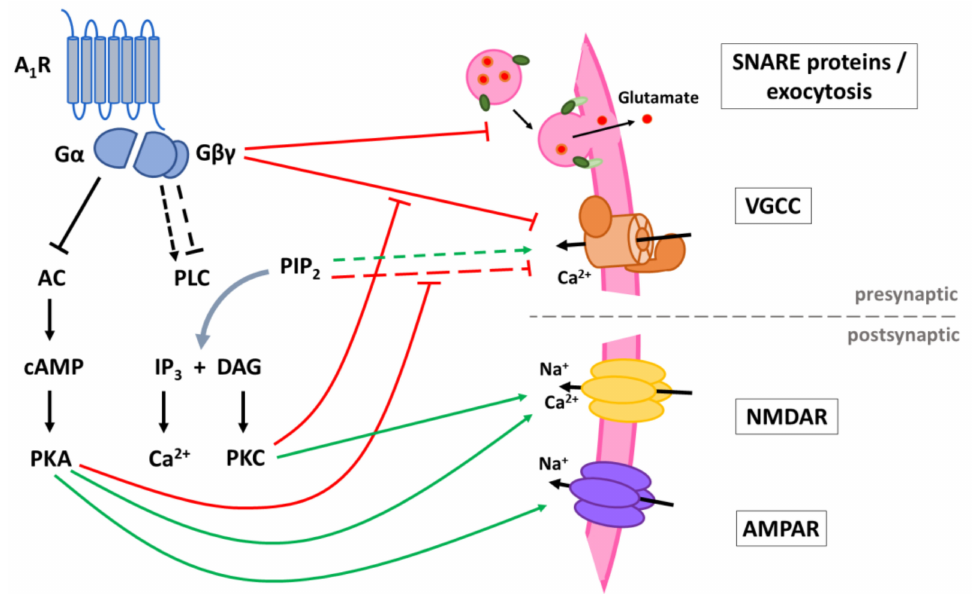
Figure 4. Schematic representation of the signaling pathways involved in the suppression of neurotransmission by adenosine A 1 receptors (A 1 R). A 1 Rs suppress neurotransmitter release in a Ca 2+ -dependent way by inhibiting voltage-gated Ca 2+ channels (VGCCs) via G βγ . Additionally, VGCCs are inhibited through reduced PLC signaling resulting in reduced disinhibition by PKC and increased inhibition by PIP 2 . Inhibition of PKA activity by A 1 R also enhances PIP 2 -mediated inhibition of VGCCs. Through binding of G βγ to SNARE proteins, A 1 Rs also suppress neurotransmitter release in a Ca 2+ -independent way. Postsynaptic NMDA (NMDAR) and AMPA receptor (AMPAR) function is negatively modulated by A 1 Rs through inhibition of PKA and PKC activity. AC: adenyl cyclase; cAMP: cyclic adenosine monophosphate; PKA: protein kinase A; PLC: phospholipase C; PIP 2 : phosphatidylinositol 4,5-bisphosphate; IP 3 : inositol 1,4,5-trisphosphate; DAG: diacylglycerol; PKC: phosphokinase